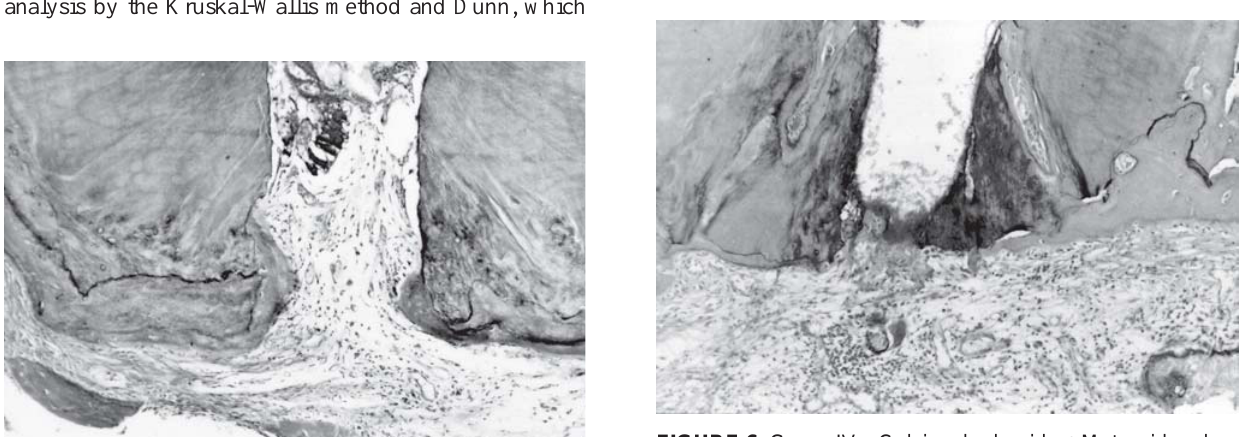
FIGURE 6- Group IV – Calcium hydroxide + Metronidazole – Partial biological closure of the main foramina and complete biological closure of some apical branches. Repair of areas of cemental resorption and presence of a moderate chronic inflammatory infiltrate in the periodontal ligament. H. E., 100X